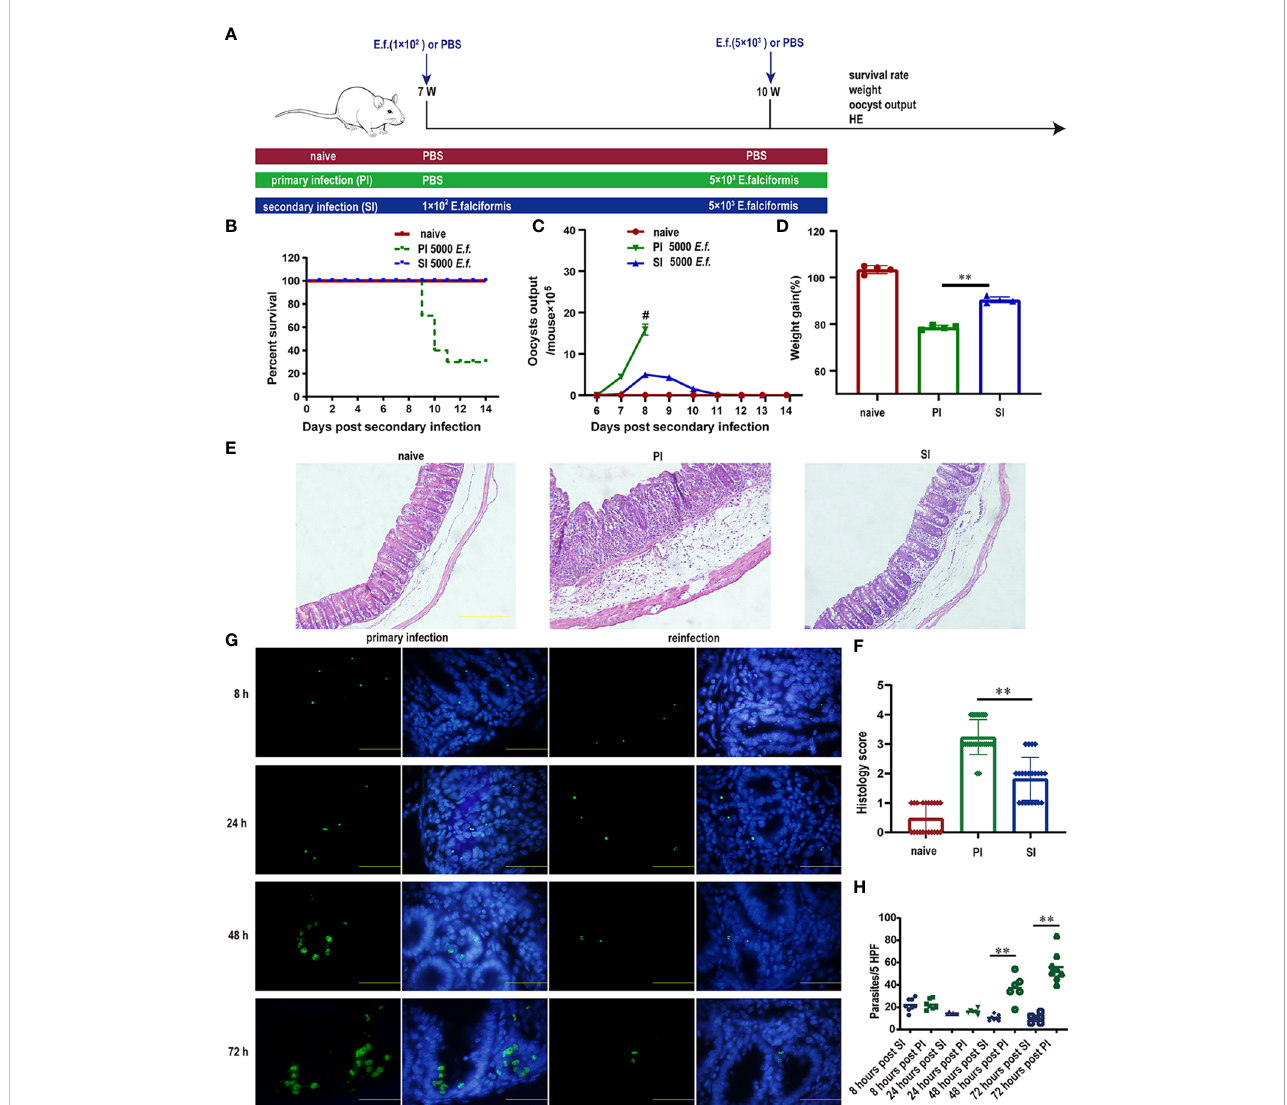
FIGURE 1 Protective immunity induced by primary E. falciformis ( E.f. ) infection targeted early schizonts. (A) Experimental design for E. falciformis primary infection and reinfection. Naïve mice remained uninfected for the duration of study. For the infected mice, each infection doses is indicated. (B) Survival curves after primary infection and secondary infection with 5000 oocysts of E. falciformis . n =9 per treatment group. (C) Kinetics of oocyst output at 6-13 days post primary infection and reinfection with 5000 oocysts of E. falciformis , # denotes the mice with severe diarrhea, to the extent that faeces collection was not possible. n =6 per treatment group. (D) Body weight change at 8 days post primary infection and secondary infection with 5000 E. falciformis . n =4 per treatment group. (E) H&E staining of cecum from mice at 5 days after primary infection and reinfection with 5000 E. falciformis . n =3 per treatment group, magni fi cation ×200. (F) Histology scoring of cecum at 5 days after primary infection and reinfection with 5000 E. falciformis . (G) Frozen sections for E. falciformis (green) and DAPI (blue) in cecum from single infected and reinfected mice (to visualize parasites in the cecum at 8 and 24 h post infection,